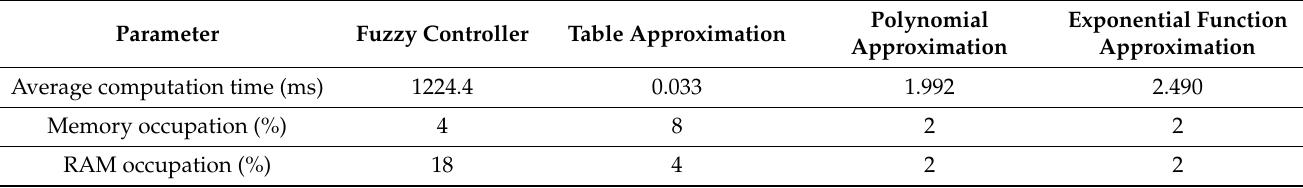
Table 3. Comparison of computation load of C8051F340 microcontroller with fuzzy controller and approximation methods. Parameter Fuzzy Controller Table Approximation